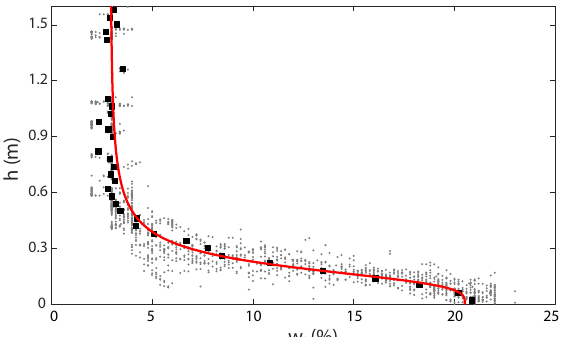
Figure 11. Groundwater depth ( h ) versus surface moisture content ( w s ). The gray dots are the individual observations measured with the Theta probe. The squares are the mean values in 0.04 m bins. The red line is the fitted Van Genuchten relationship, (Equation (2)), to the binned values. The r 2 is 0.997 and the standard error is